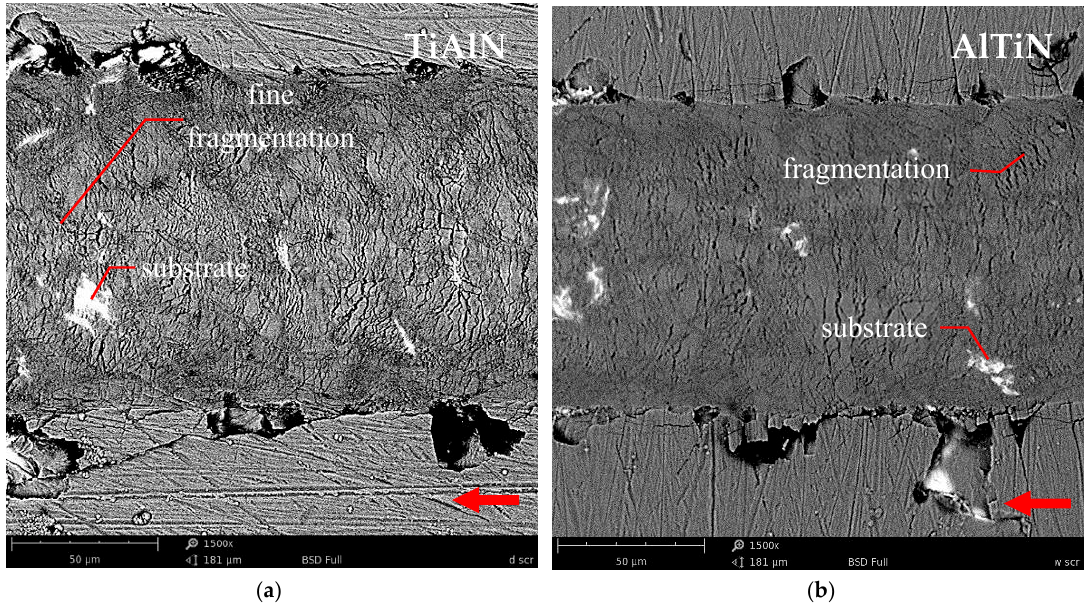
Figure 2. Comparison of the films at the end of the scratch trace, scratch direction marked by an arrow. ( a ) TiAlN; ( b ) AlTiN, magnif. 1500 × , SEM.